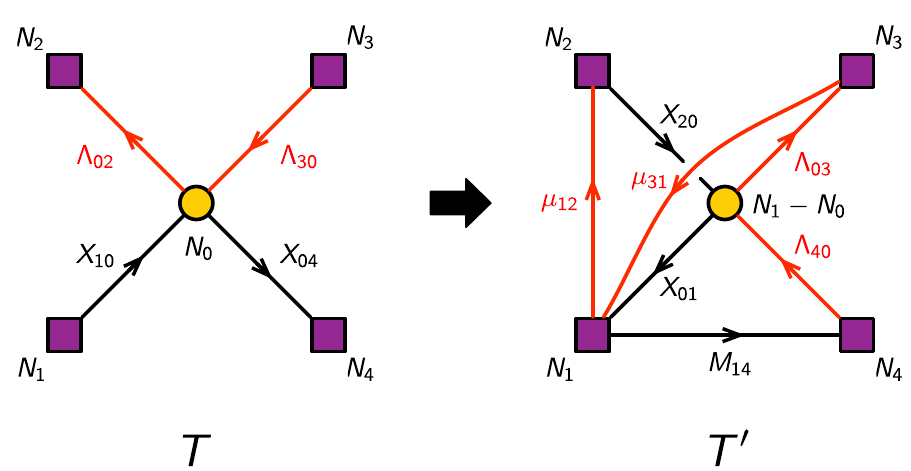
Figure 8 . Quiver diagrams for the initial theory T and its quadrality dual T 0